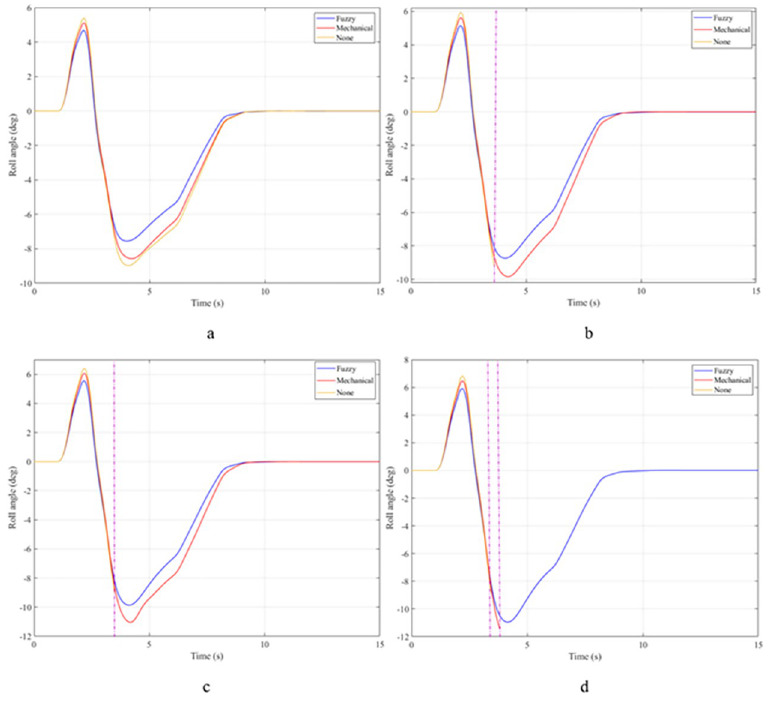
Fig 17. Roll angle.